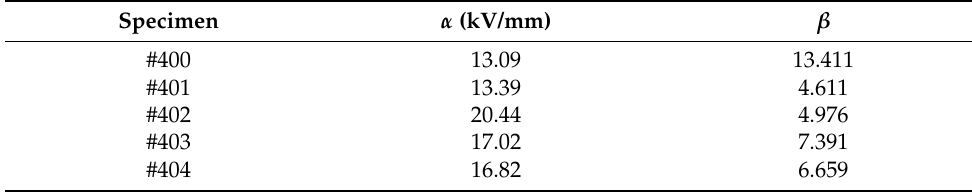
Table 2. Weibull parameters of samples with different SiO 2